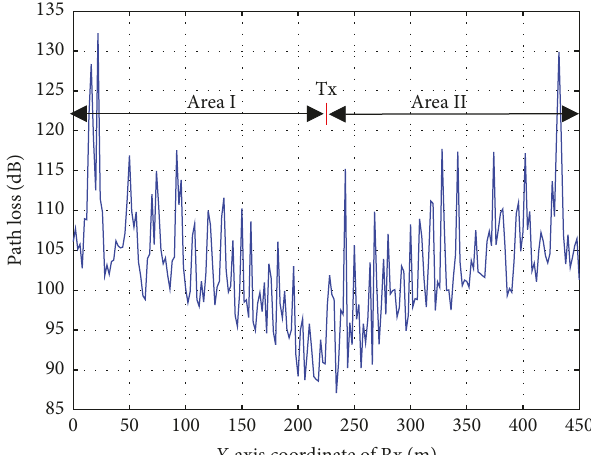
Figure 3: Path loss.